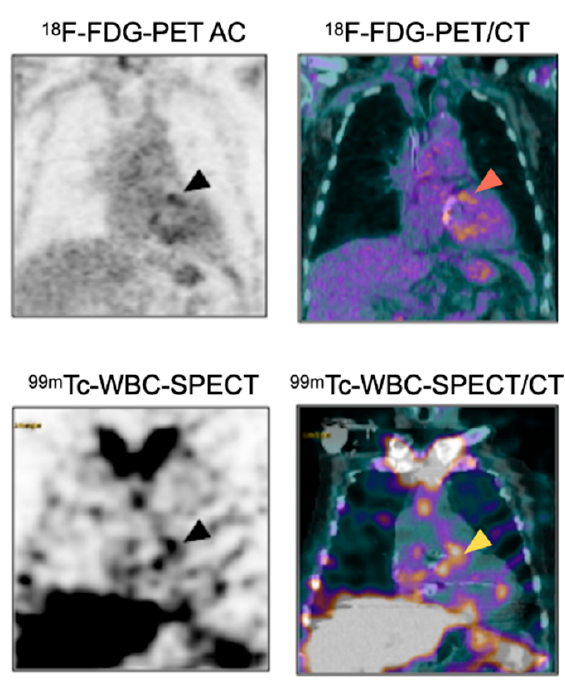
Figure 5. Complementary diagnostic value of 18 F-FDG-PET/CT and 99m Tc-WBC-SPECT/CT for the diagnosis of PVE. Patient with suspicion of aortic PVE one month after surgery. 18 F-FDG-PET/CT showed intense uptake around the aortic prosthetic valve (arrowheads), which could in this context be related to PVE or to post-surgery inflammatory reaction. 99m Tc-WBC accumulation in the same area as the 18 F-FDG-PET/CT helped to confirm the diagnosis of prosthetic valve infection.